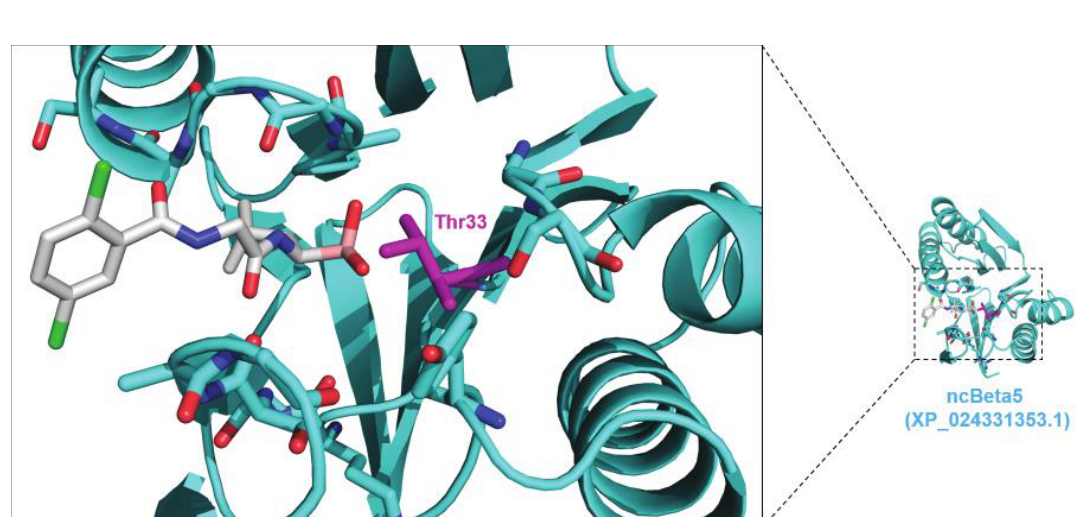
Figure 2. Conservation of key sequence and structural features of the β 5 active site. ( A ) Sequence alignment of the 20S proteasome β 5 subunit from H. sapiens (NP_002788.1), A. mellifera (XP_394680.3), N. ceranae (XP_024331353.1), E. hellem (XP_003887862.1), and S. cerevisiae (NP_015428.1). Amino acids from the catalytic triad (T1, D17, and K33 numbered from processed H. sapiens protein [83]) are boxed in green and amino acids critical for binding proteasome inhibitors (T2, R19, A20, T21, A22, G23, K33, A46, G47, G48, A49, A50, G129, S130, Y169, numbered from processed H. sapiens protein [82]) are boxed in red. The processing site for generating the mature protein is denoted with a red line. ( B ) Homology model of N. ceranae β 5 bound to ixazomib. The β 5 subunit is shown in ribbon mode. Residues forming electrostatic interactions with ixazomib in the crystal structure of ixazomib with the human CP are shown in stick mode, with the catalytic threonine colored magenta. Ixazomib is shown in stick mode with the boronate boron atom colored